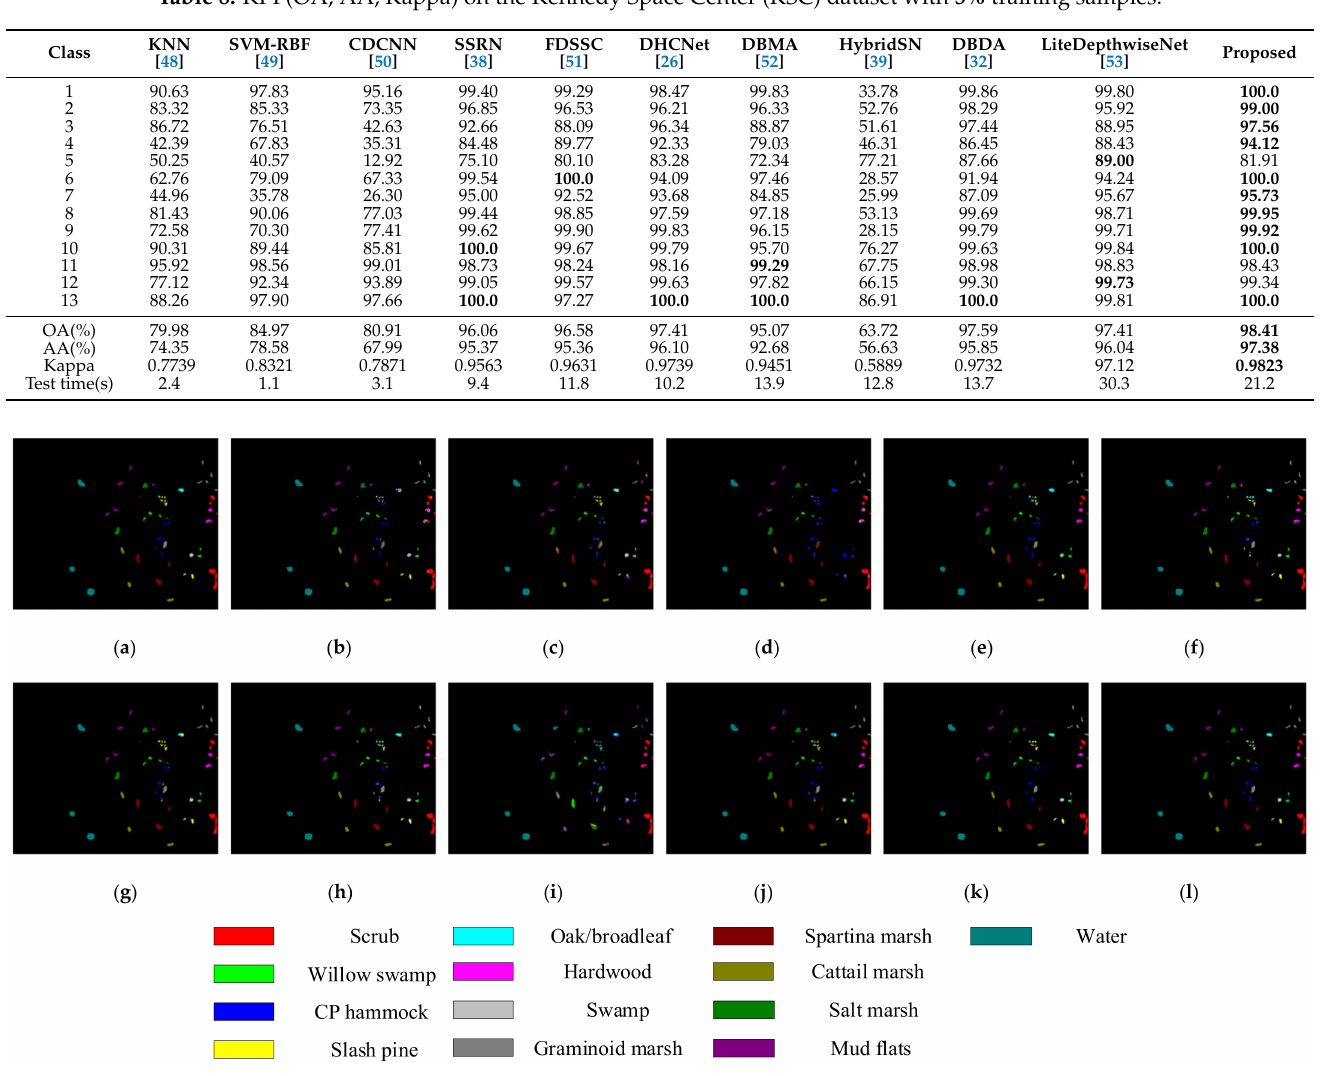
Figure 9. Full classification maps on the Kennedy Space Center images obtained with the ( a ) ground truth, ( b ) KNN (OA = 79.98), ( c ) SVM-RBF (OA = 84.97), ( d ) CDCNN (OA = 80.91), ( e ) SSRN (OA = 96.06), ( f ) FDSSC (OA = 97.58), ( g ) DHCNet (OA = 97.41), ( h ) DBMA (OA = 95.07), ( i ) HybridSN (OA = 63.72), ( j ) DBDA (OA = 97.59), ( k ) LiteDepthwiseNet (OA = 97.41), and ( l ) proposed method (OA = 98.41). Table 9. KPI (OA, AA, Kappa) on the Salinas Valley (SV) dataset with 0.5% training